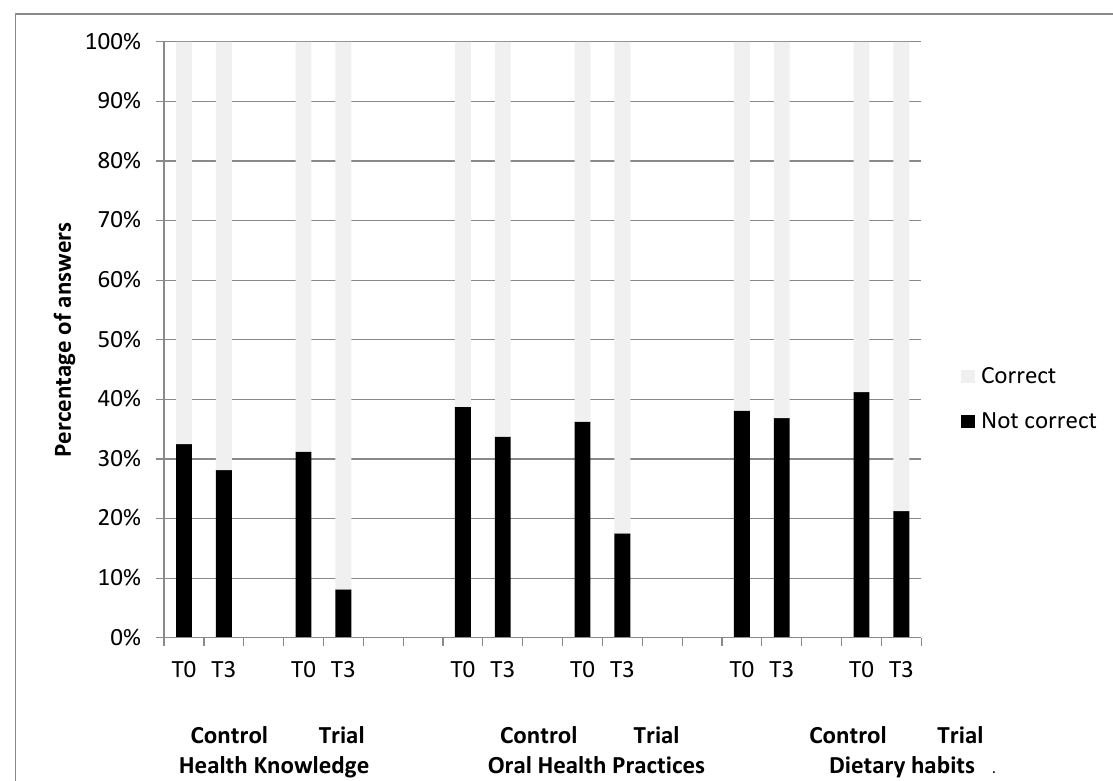
Figure 5. Frequency distributions of questionnaire answers.